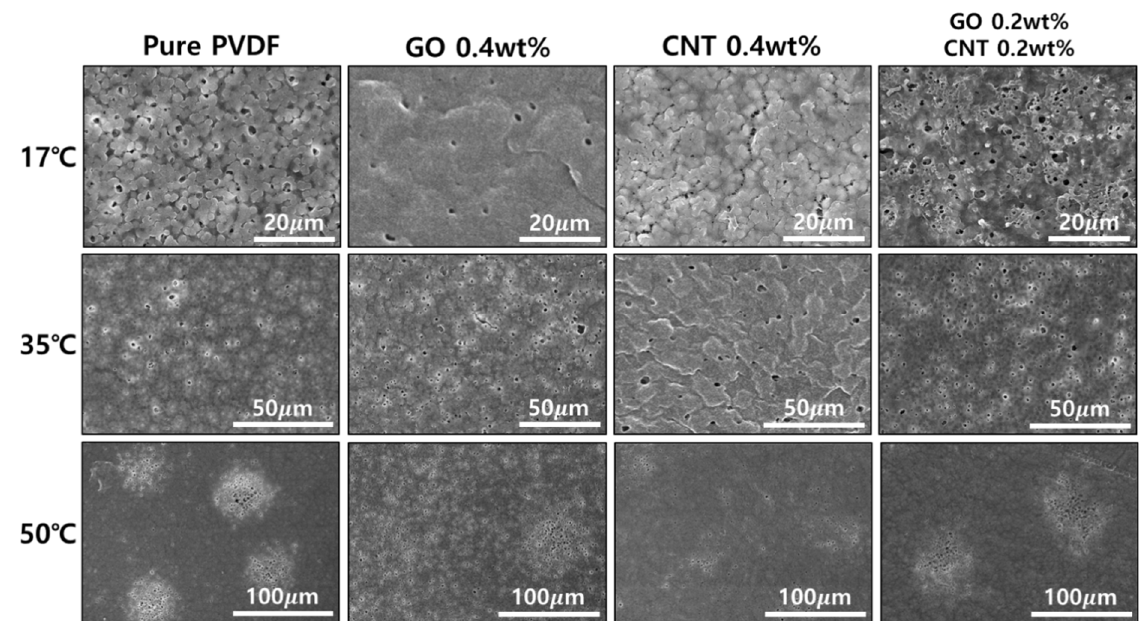
Figure 3. FE-SEM images of the surface of PVDF membranes according to various GO and MWCNT contents and coagulation temperatures, respectively.